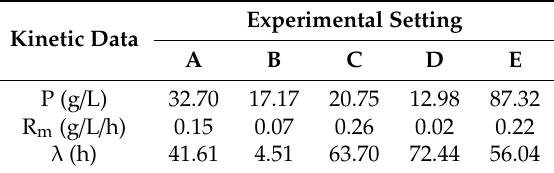
Table 4. Results of the kinetic process evaluation based on the data from Table 2.